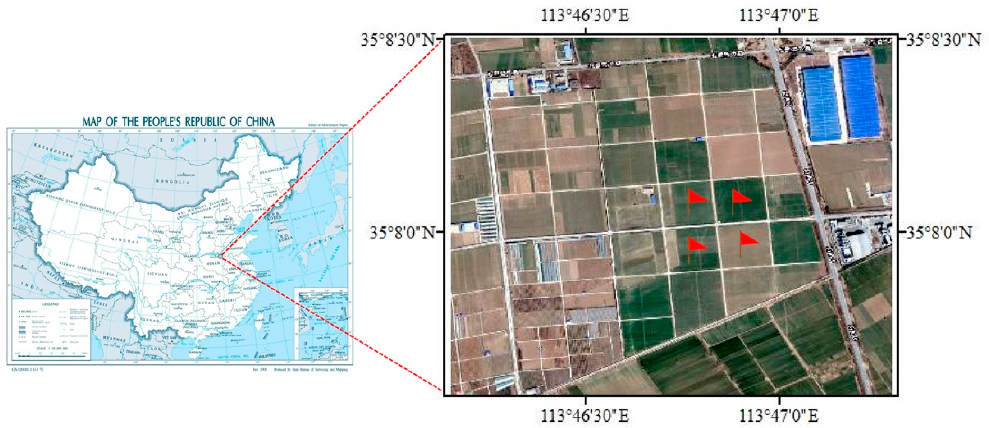
Figure 2. The test location and the brief overview of the studied wheat field. The experimental fields are marked with red flags.